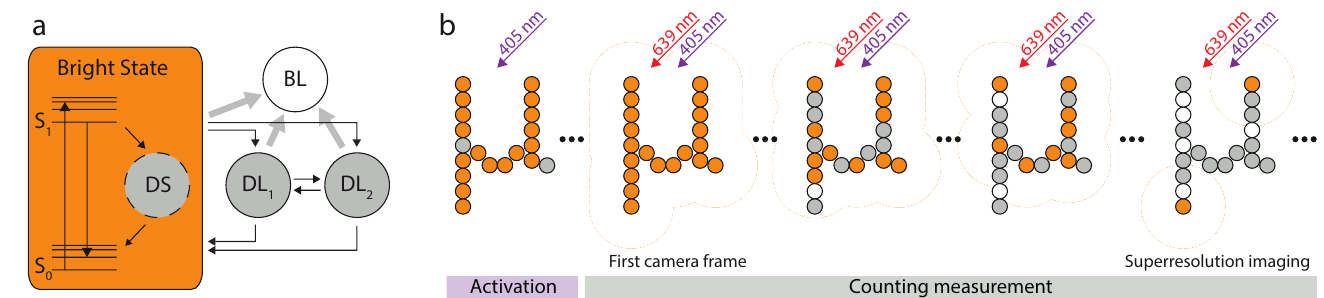
Figure 3. Photophysical model for Alexa 647 and imaging protocol. ( a ) The photophysical model for Alexa 647 exhibits three dark states. DS accounts for the excess variance observed in single molecule traces. DL 1 and DL 2 account for the triplet and an even longer living dark state respectively. ( b ) At the beginning of the measurement all fluorophores are activated by UV-illumination. Recording starts when the excitation laser is switched on. The first frames are used for counting only. Once the blinking has become sufficiently sparse, the data is also used for sub-diffraction